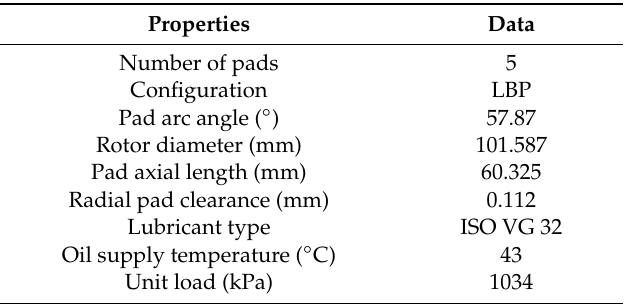
Table 1. Test bearing parameters.